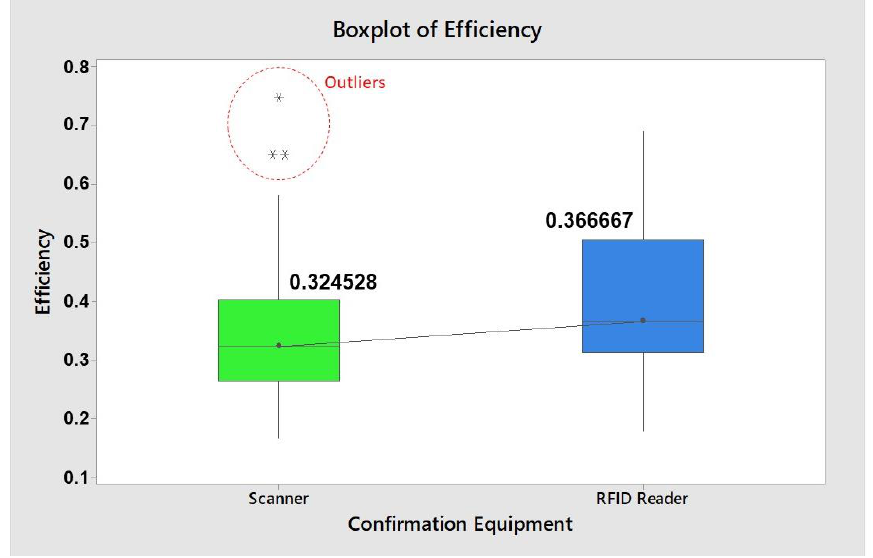
Figure 11. Boxplot of order-picking time for confirmation equipment (* represents outlier values).